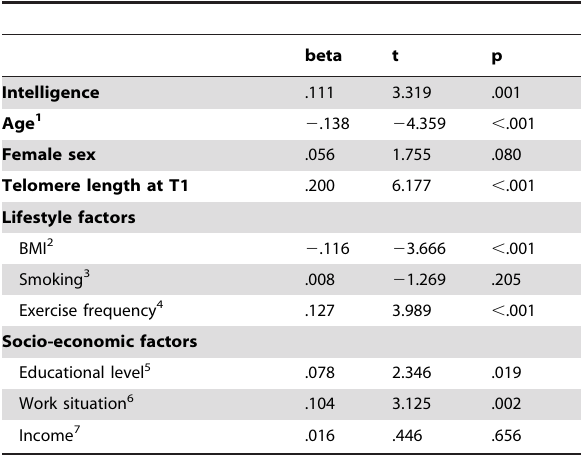
Table 2. Univariable associations between predictors and telomere length at